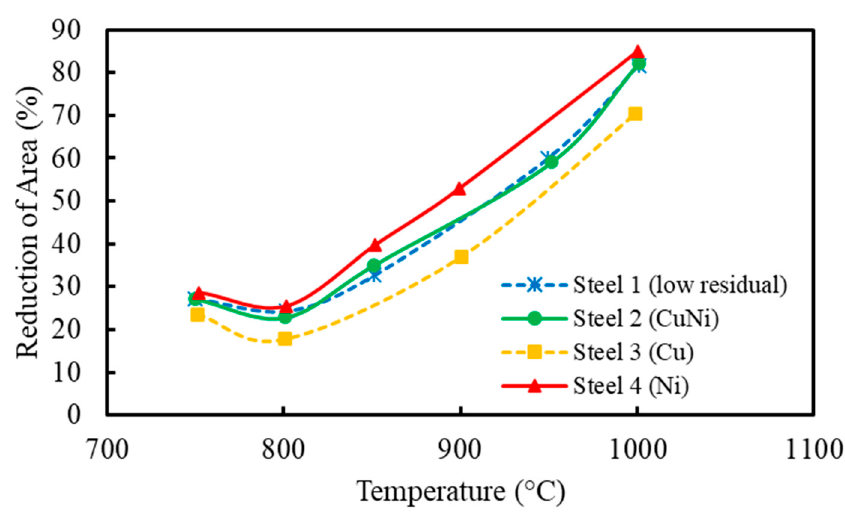
Figure 6. Hot ductility curves for as-cast tensile specimens of C-Mn-Al-Nb steels tested in “air” (argon flow discontinued). Steel 1 has the base composition, having a residual Cu content with no Ni. Steel 2 has additions of 0.25% Cu and 0.25% Ni. Steel 3 has additions of 0.5% Cu and no Ni, Steel 4, additions of 0.5% Ni and no Cu [18].